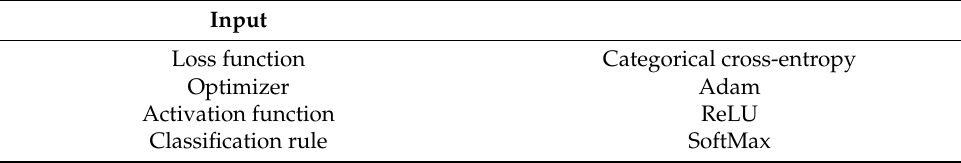
Table 6. Hyperparameters.